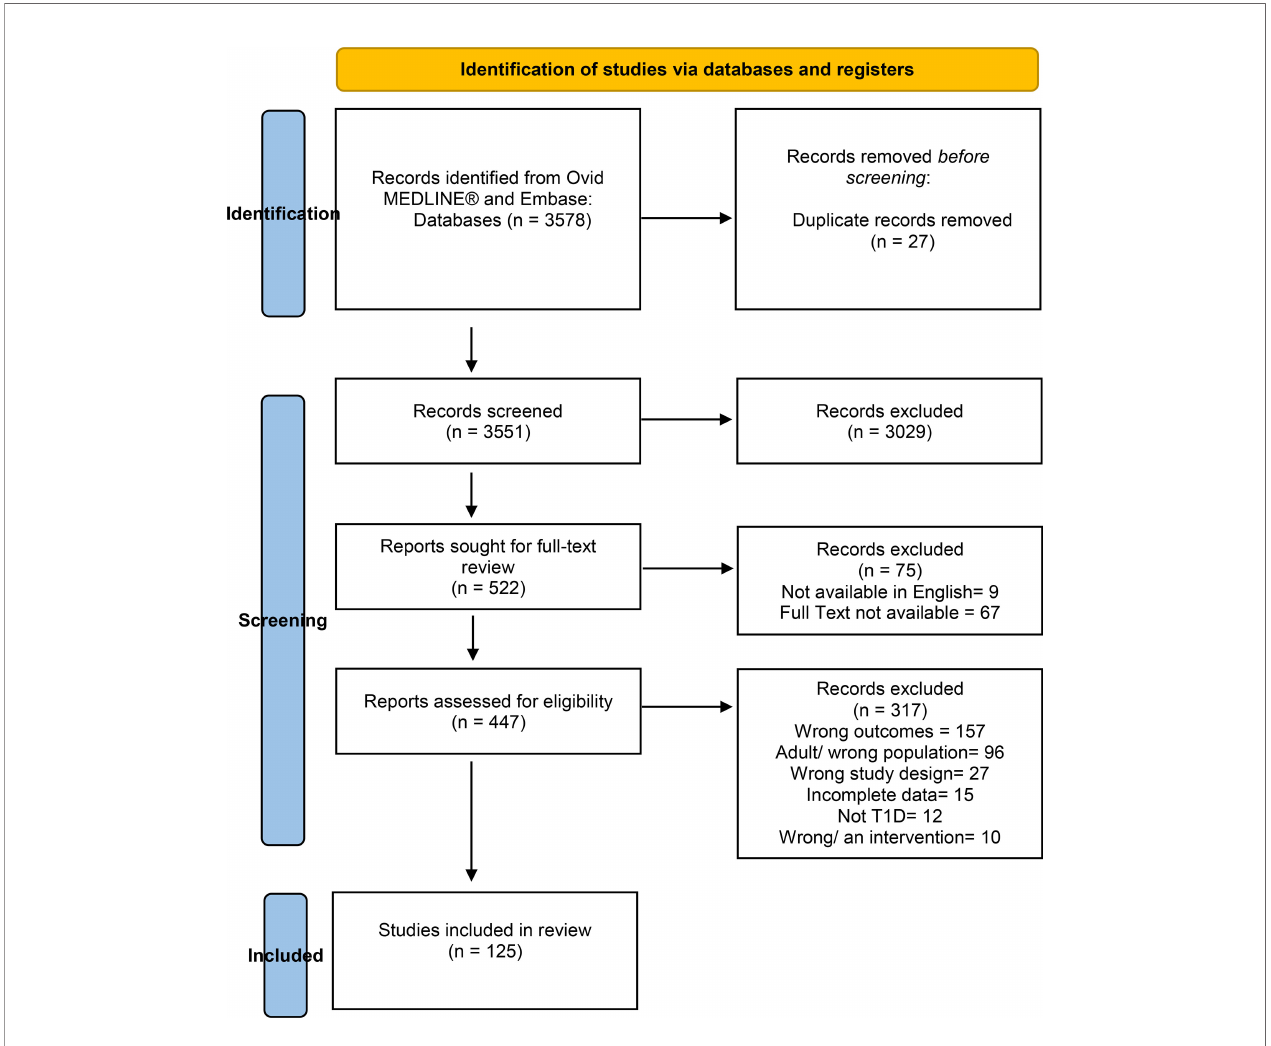
FIGURE 1 | PRISMA fl ow diagram of study selection.